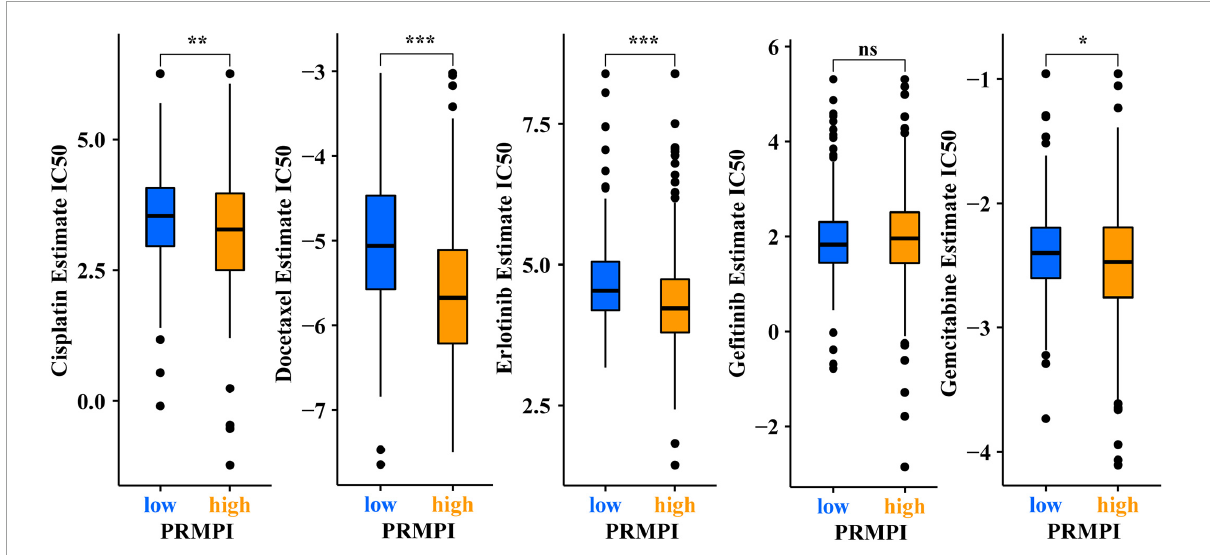
FIGURE8 Pyroptosis-related mRNA prognostic index (PRMPI) may be a potential predictor of sensitivity to chemotherapy and targeted therapy, as high-PRMPI scores are associated with lower IC50 of targeted therapy and chemotherapy (* p -value < 0.05; ** p -value < 0.01; and *** p -value < 0.001). ns, no